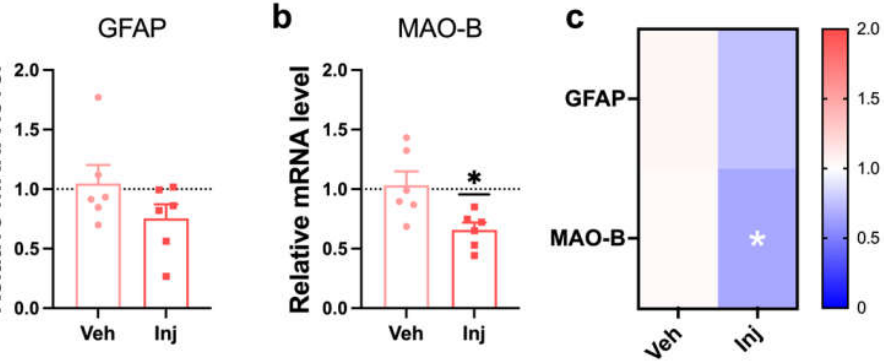
Figure 6. Vitamin D supplementation in a late-stage attenuated reactive astrocyte. ( A , B ) The qRT-PCR results from the analysis of the mRNA expression of ( A ) GFAP and ( B ) MAO-B in the Veh ( n = 6) and Inj ( n = 6) groups are shown. ( C ) A heatmap of the relative levels of mRNA expression related to a reactive astrocyte was used to compare the Veh ( n = 6) and Inj ( n = 6) groups. The data are presented by the mean ± SEM of each group. * p < 0.01 by the Student’s t -test.